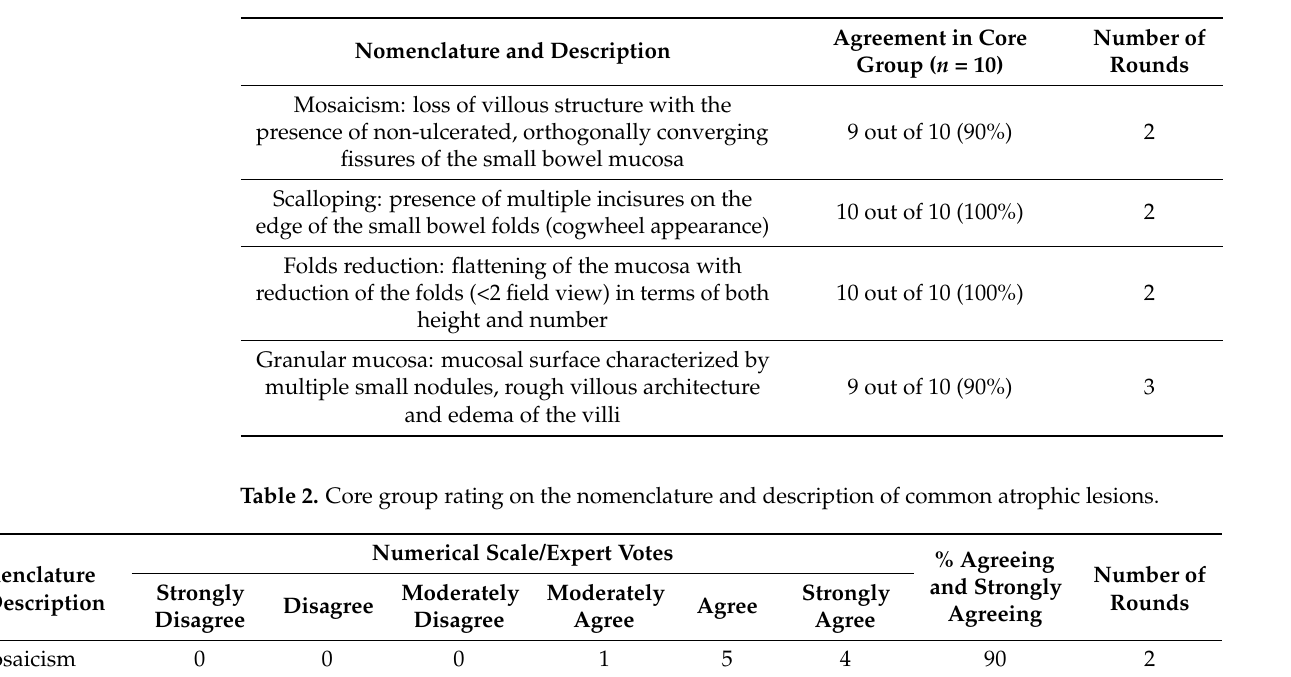
Table 1. Core group agreement for nomenclature and description of common atrophic lesions.